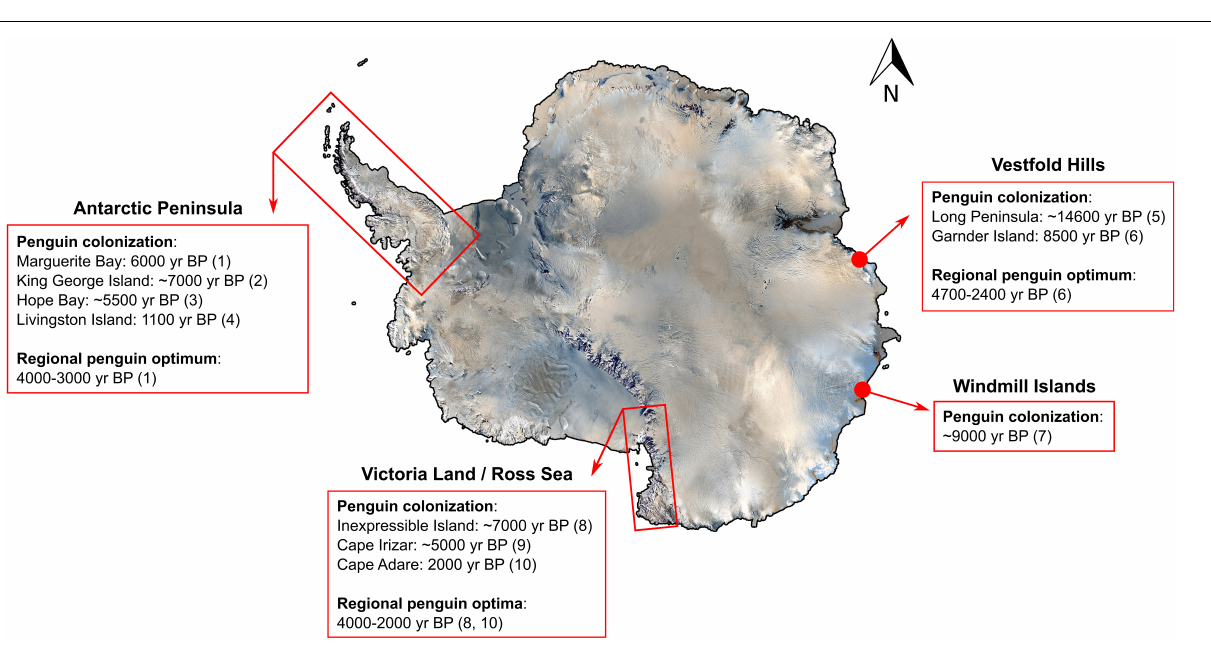
Frontiers in Ecology and Evolution |